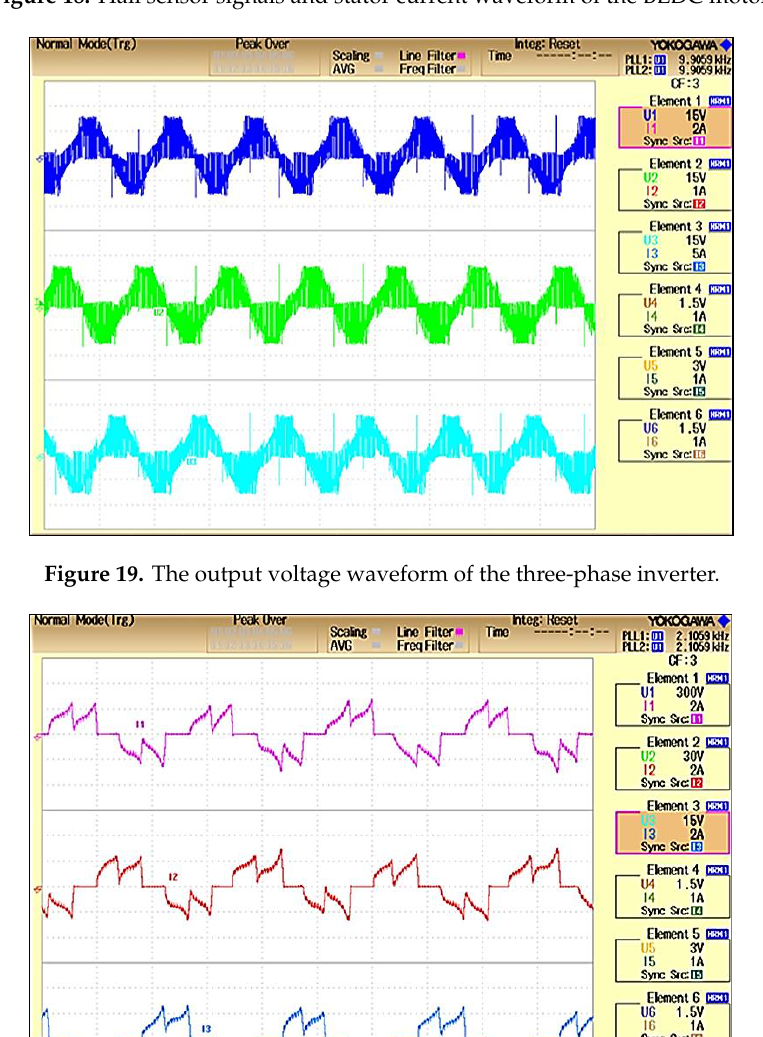
Figure 21. Speed waveform of the BLDC motor. 6. Conclusions The modified LUO converter-fed VSI-BLDC motor with a solar PV array for a water pumping application was developed using MATLAB/Simulink and the Simpower system toolbox, whose suitability was exhibited by simulated results. Initially, to meet the various desired objectives, the developed system was logically designed. The proposed method was simulated and modelled to evaluate the performance under initial and steady-state conditions. The integration of the modified LUO converter was justified by evaluating its performance with the SPV array-based water pumping BLDC motor drive. The developed method availed many desired operations such as the absorption of MPP from the SPV array, BLDC motor soft starting, the fundamental switching frequency of the VSI (resulting in low switching losses), a reduction in the switch stress and the continuous conduction mode of the modified LUO converter for stable operation. Even at a very low solar irradiance, the developed method was operated successfully. The GWO-optimized algorithm optimally extracted maximum power from the PV system when compared to the P&O and Fuzzy logic MPPT algorithms. The scaling-up of the power rating of the